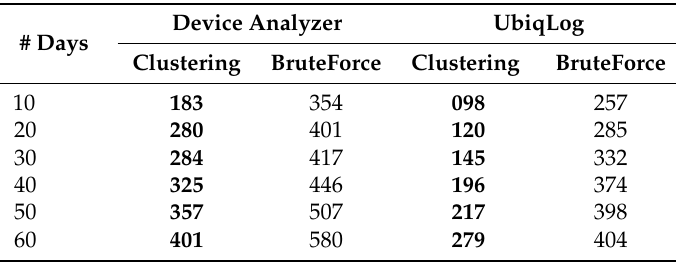
Table 8. Energy use in micro-Watt (mW) comparing brute force and our cluster based search